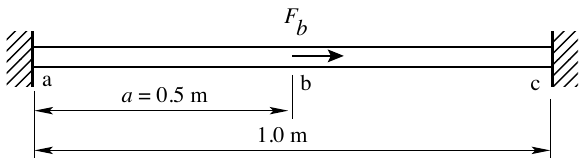
Fig. 3. Forced vibration of fixed-fixed bar.